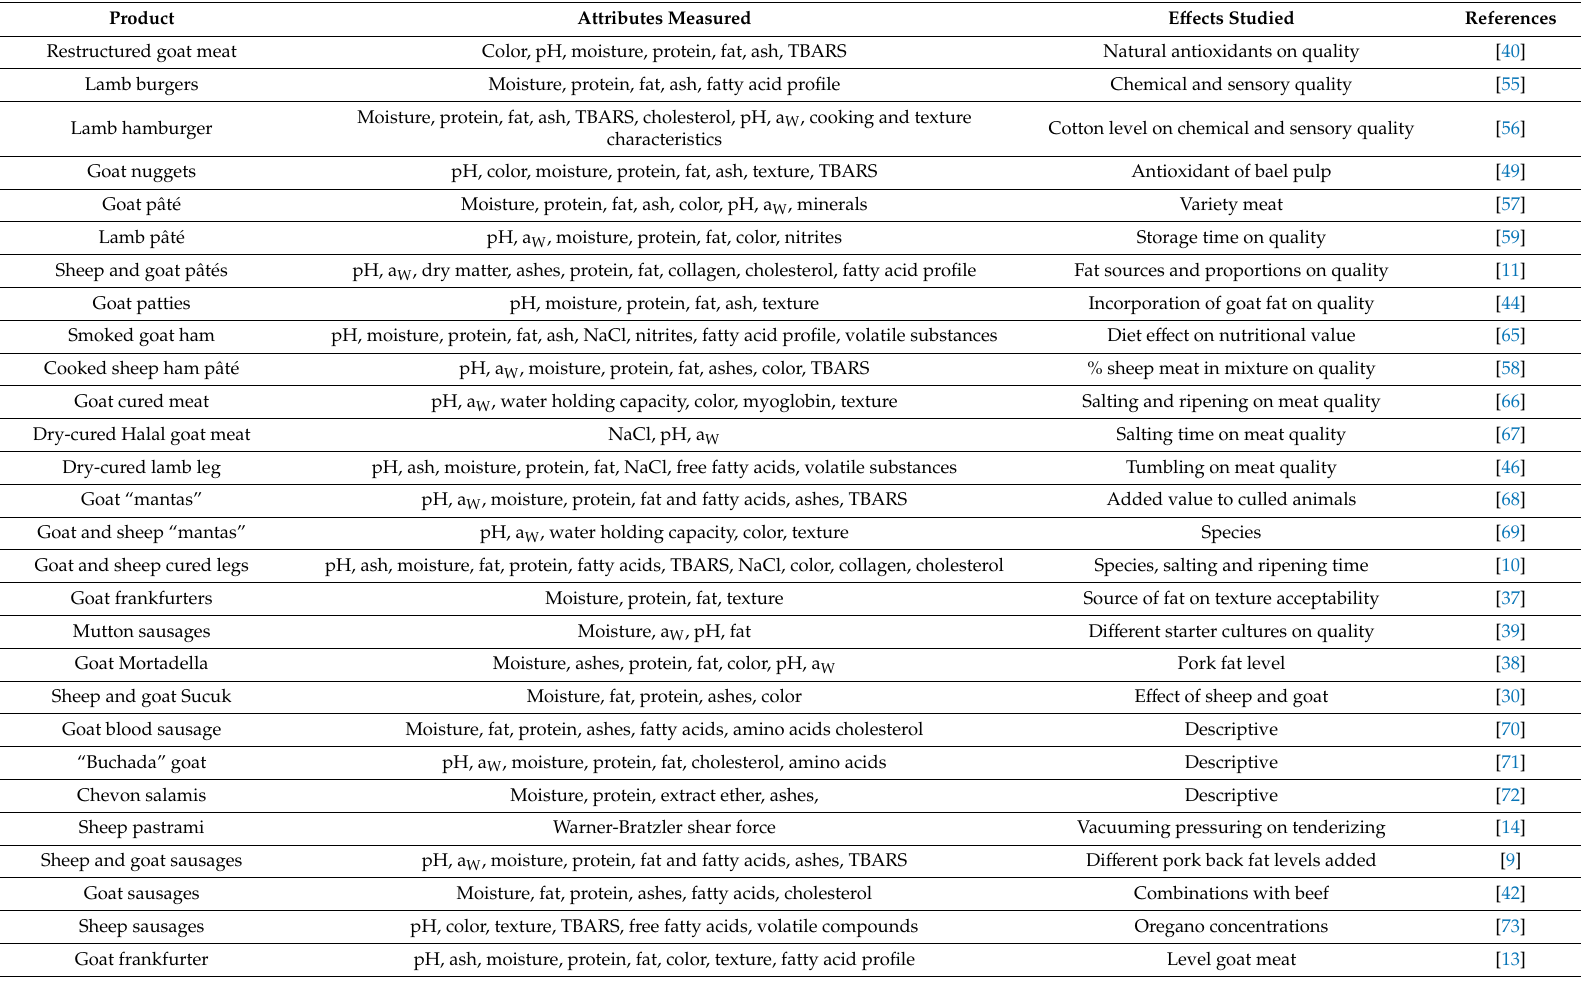
Table 1. Summary of the principal studies and attributes measured on the physicochemical characterizations of processed sheep and goat meat